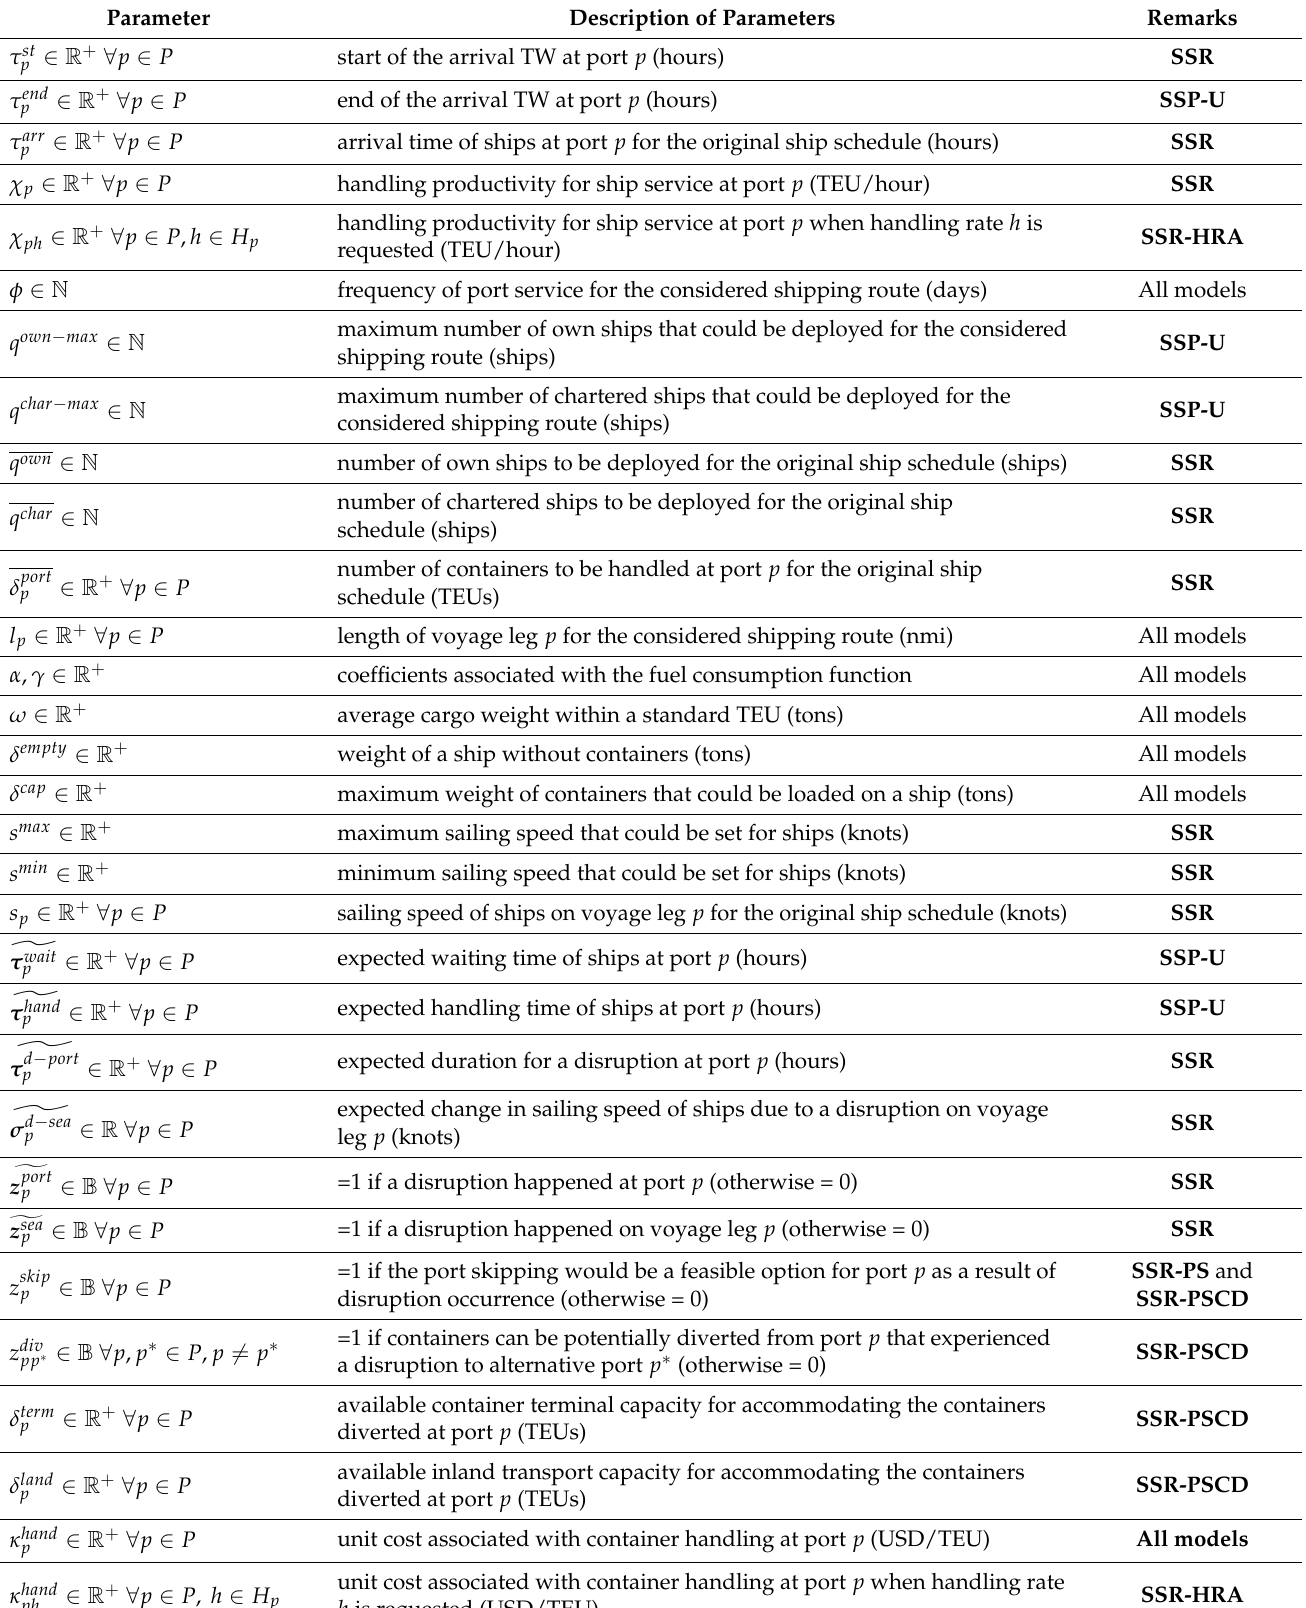
Table A4. Definition of